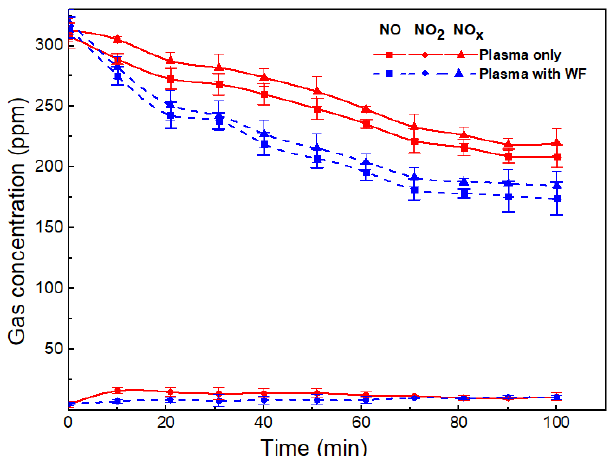
Figure 1. Gas concentrations versus elapsed time at plasma w / o wood fiber; applied voltage 7.5 kV and SED 50 J / L (error bars indicate the standard deviation).